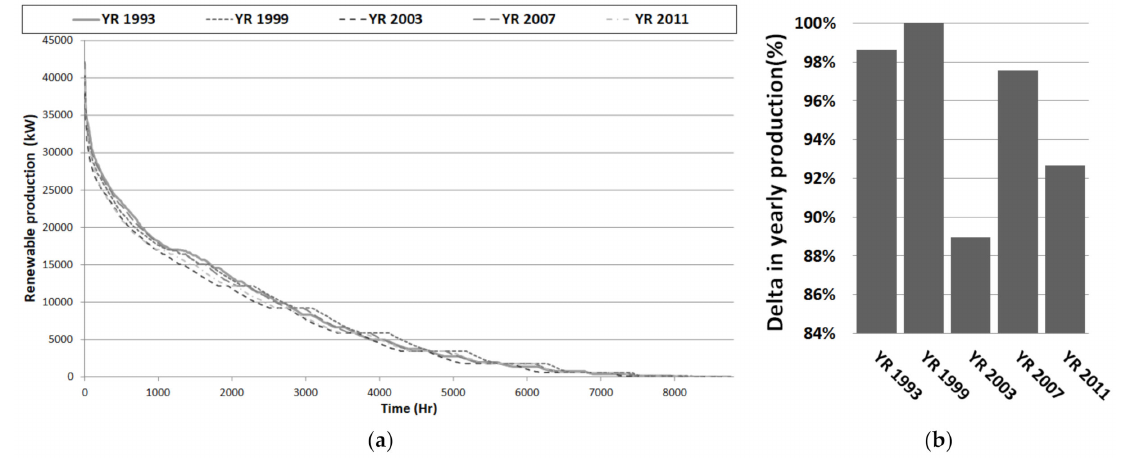
Figure 7. ( a ) LDC curve of RE 100% scenario with different weather patterns (50 solar PV and 50% wind installed capacity), ( b ) Difference in yearly production RE 100% scenario for minimum and maximum years between